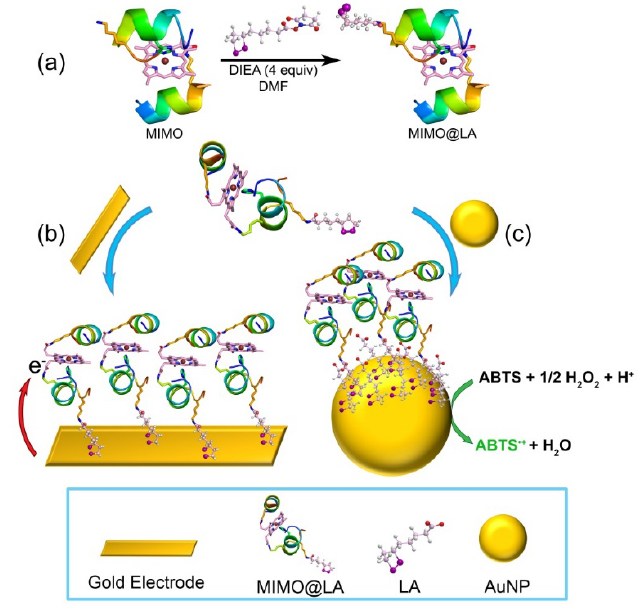
Figure 1. MIMO lipoamide (MIMO@LA): A versatile building block for the construction of synthetic gold-based biomaterials. ( a ) Strategy for MIMO@LA synthesis (DIEA: diisopropylethylamine; DMF: N , N -dimethylformamide; experimental conditions are reported in Section 3.1). ( b ) Immobilization of MIMO@LA on gold electrode affords a redox active interface. ( c ) Conjugation to gold nanoparticles (AuNPs) gives a catalytic system for substrate oxidation. The oxidation of the chromogenic substrate 2,2′-azino-bis (3-ethylbenzothiazoline-6-sulphonic acid) (ABTS) to ABTS radical cation (ABTS ●+ ) is reported as an example.